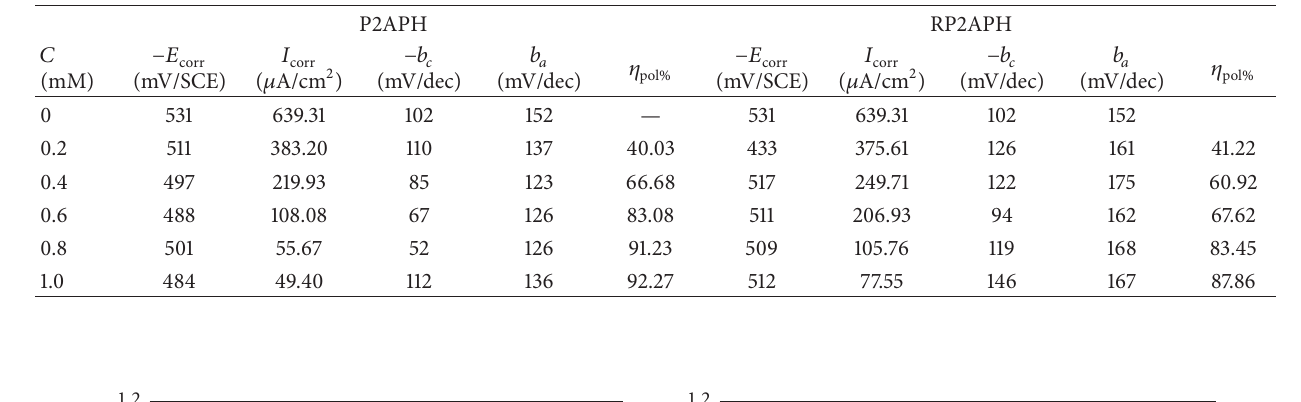
Table 2: Potentiodynamic polarization parameters of CS in the presence and absence of P2APH and RP2APH in 1 M HCl at 29 ± 0.2 ∘ C for immersion period of 30 min.